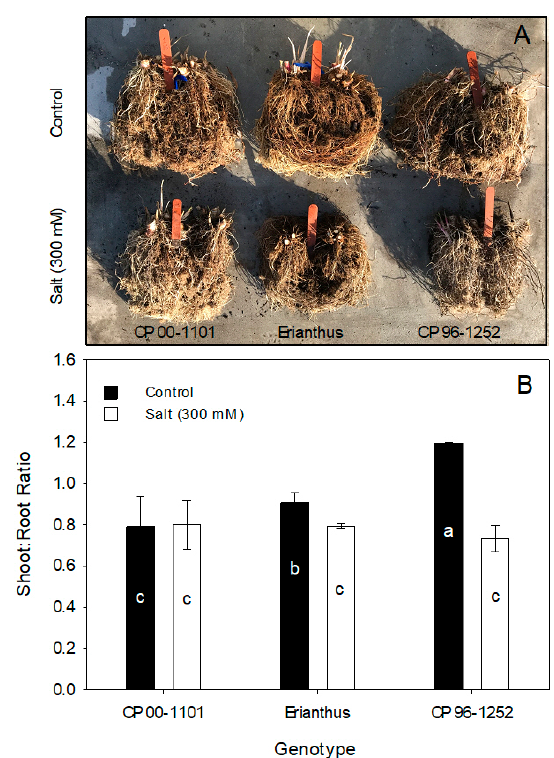
Figure 4. Effect of salinity (300 mM of NaCl added) on ( A ) roots and ( B ) shoot to root dry weight ratio of two sugarcane cultivars (CP 00-1101, CP 96-1252) and an Erianthus at 200 days after planting. Data are means ± SE ( n = 4). The values with the same letters are not significant ( p > 0.05).